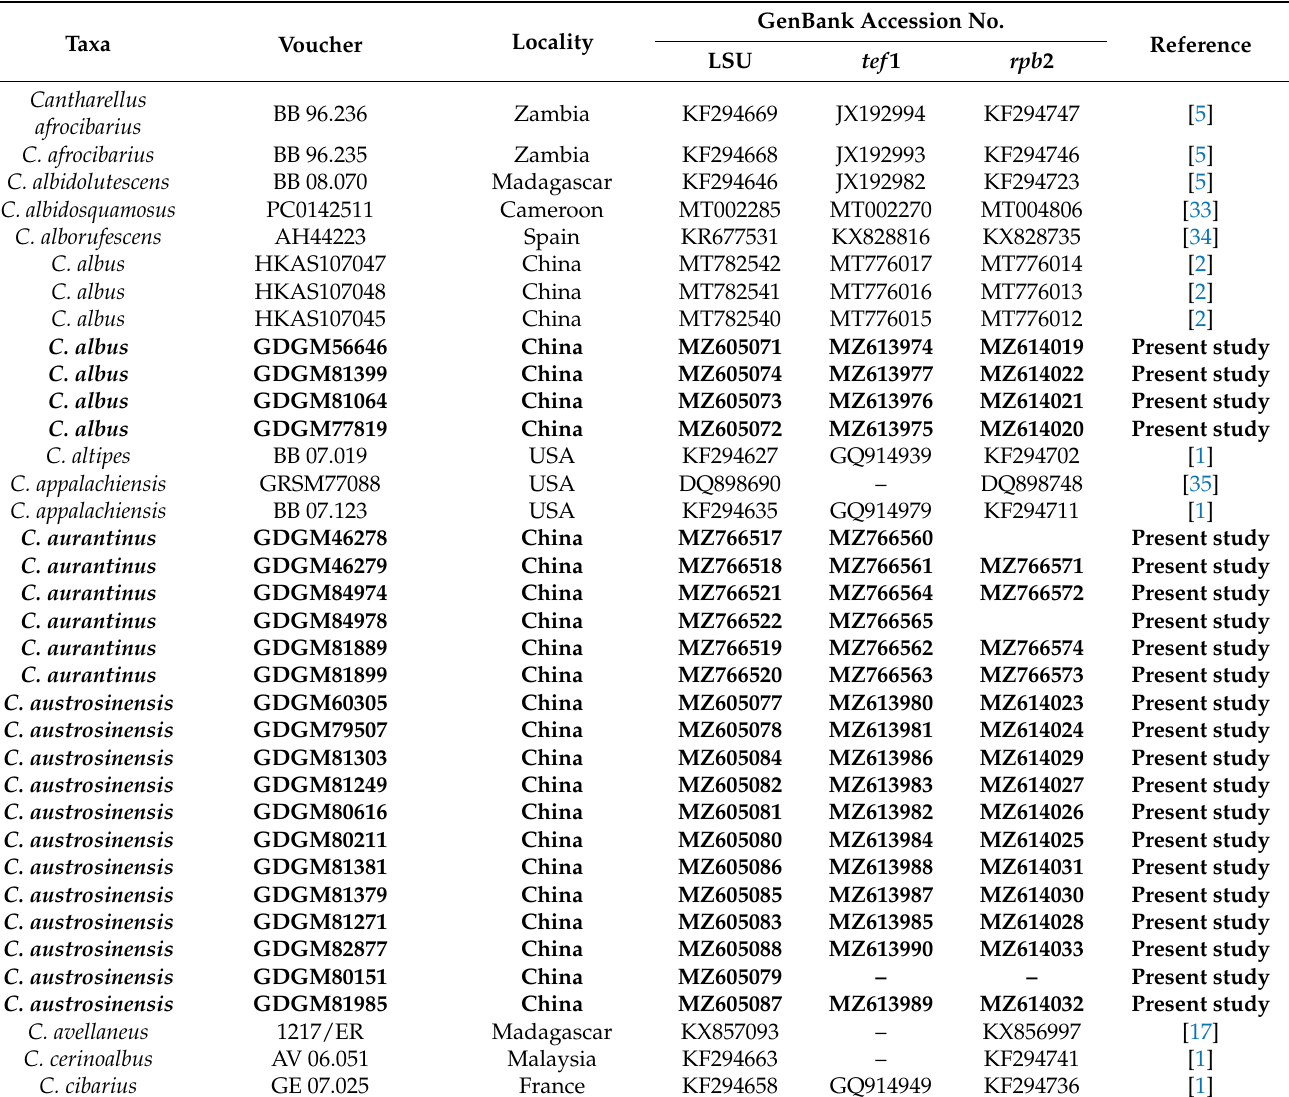
Table 1. Information on the specimens that were used in the phylogenetic analyses. Sequences that were newly generated in this study are indicated in black